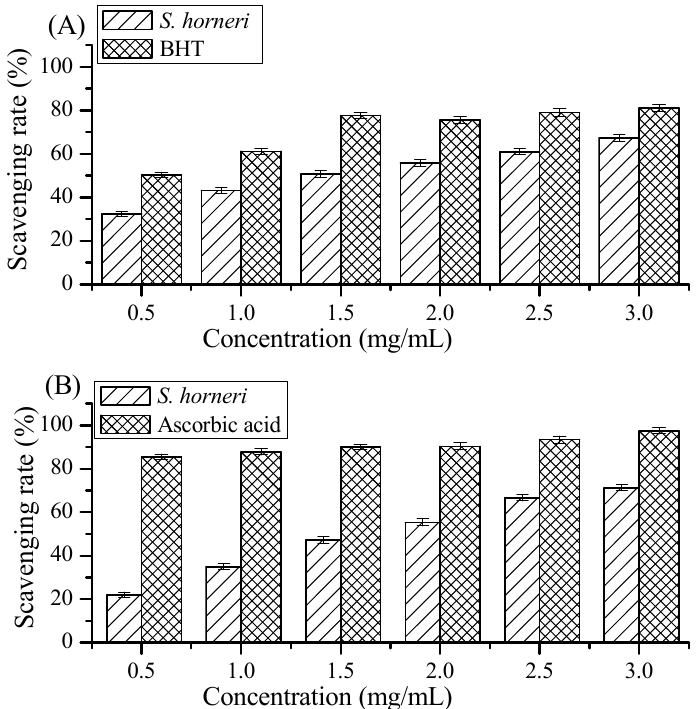
Figure 3. ( A ) Scavenging of DPPH free radicals by S. horneri polysaccharides; ( B ) Scavenging of ABTS free radicals by S. horneri polysaccharides.